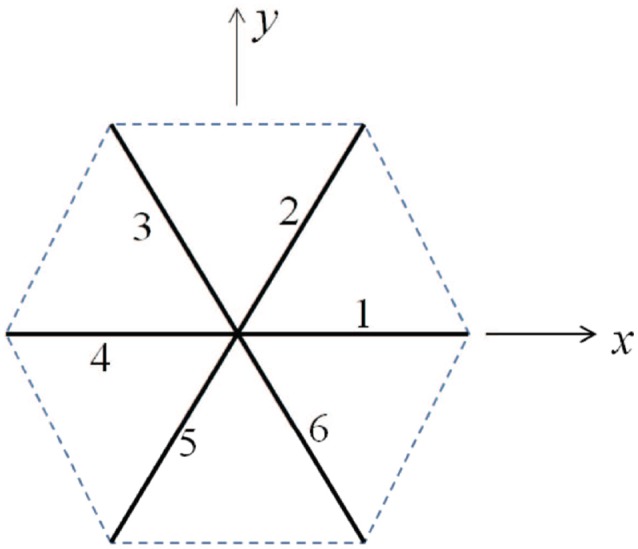
Simplified sketch of a junctional complex consisting of six Sps. The initial length of the JC spokes are taken as L0 = 40 nm here.